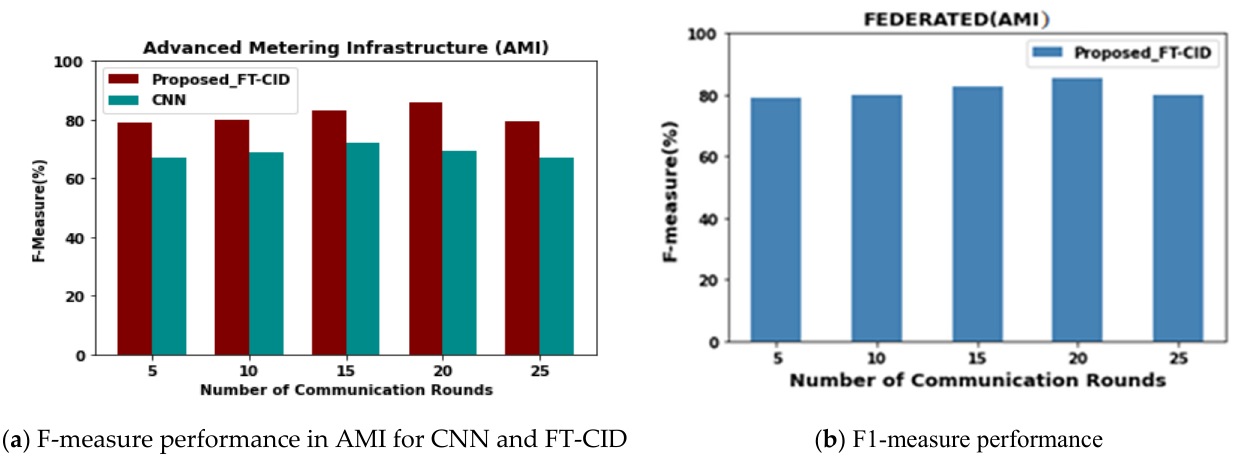
Figure 6. F-measure performance. Table 3. Comparative experimental results of F-measure.